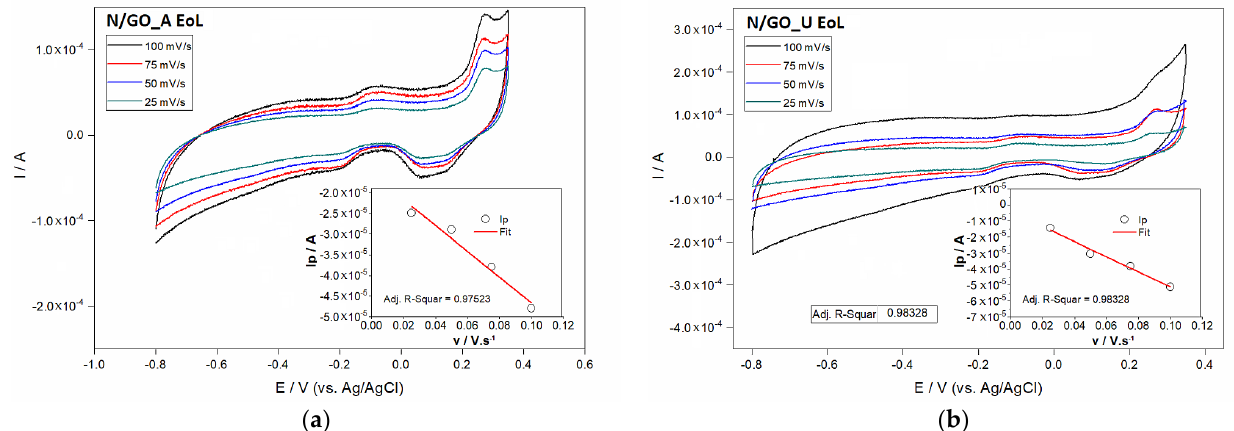
Figure 12. Chronoamperometric curves of different catalysts synthesized in the present work in 0.1 M KOH electrolyte at a constant potential of 0.3 V for 1000 min.